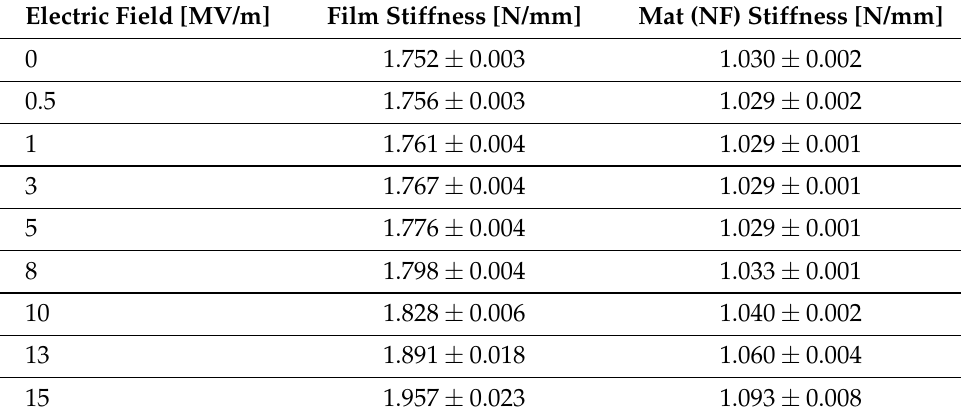
Figure 13. Force–displacement plots in the uniaxial tensile load test for ( a ) the specimen of P(VDF-TrFE-CTFE) film, ( b ) the specimen of the P(VDF-TrFE-CTFE) nanofiber (NF) mat, and ( c ) the specimen of the PFA film. Table 3. Stiffness of the specimens of the P(VDF-TrFE-CTFE) film and P(VDF-TrFE-CTFE) nanofiber (NF) mat. The reported data are the average values ± standard